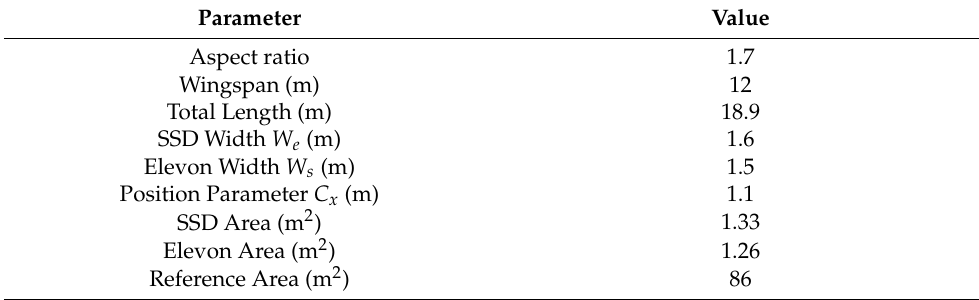
Table 1. Main parameters of the configuration and control surface.